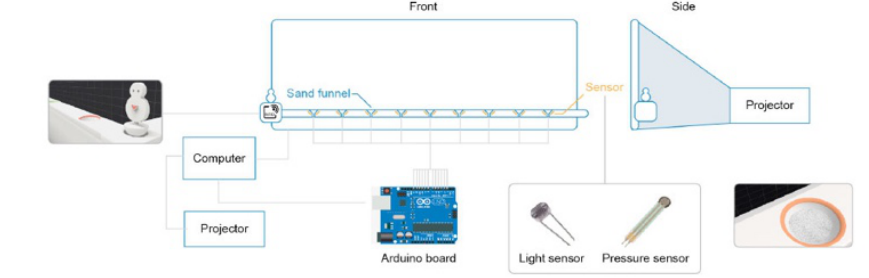
Figure 3. System structure of